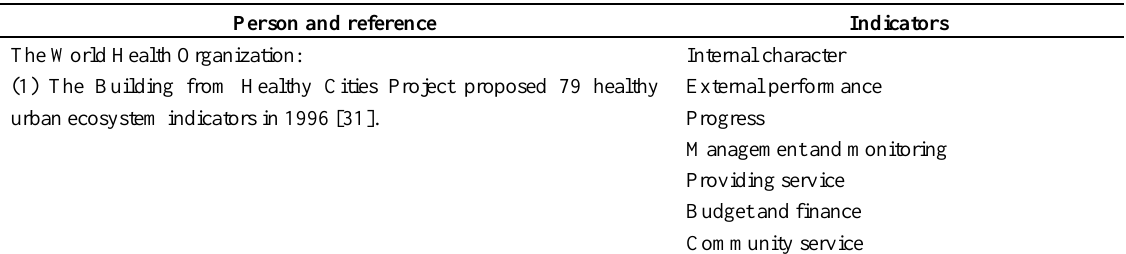
Table 1. Main related indicators for the urban ecological security